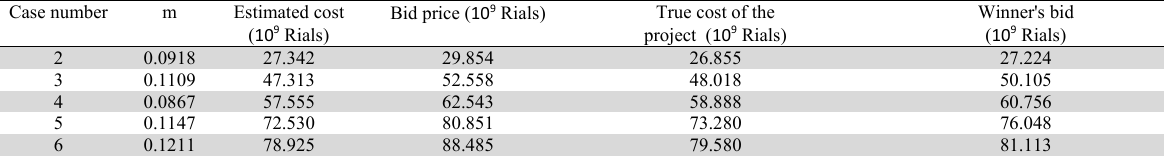
Fig. 8. Probability plot for the true cost of the project fitted by Norman function for projects 2 and 3 5. Solving the model: Now, the bid price determination for cases 2-6 can be solved by our approach. The outcomes of the cases 2-6 and also the data of what happened in practice are presented in Table 12.